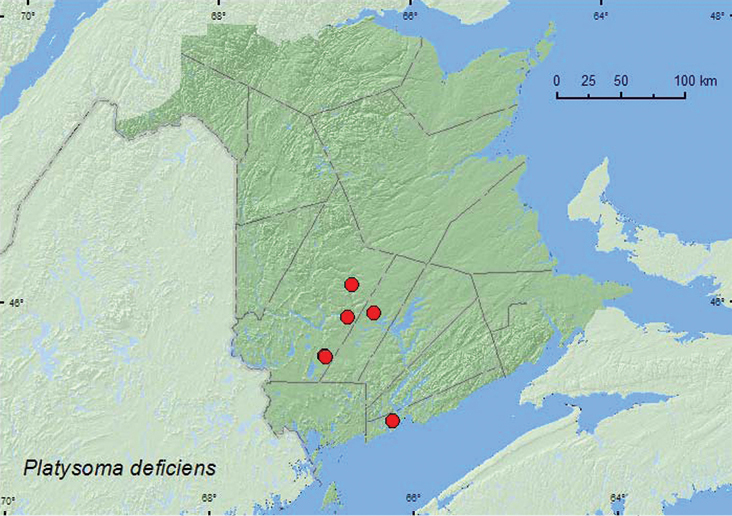
Collection localities in New Brunswick, Canada of Platysoma deficiens.